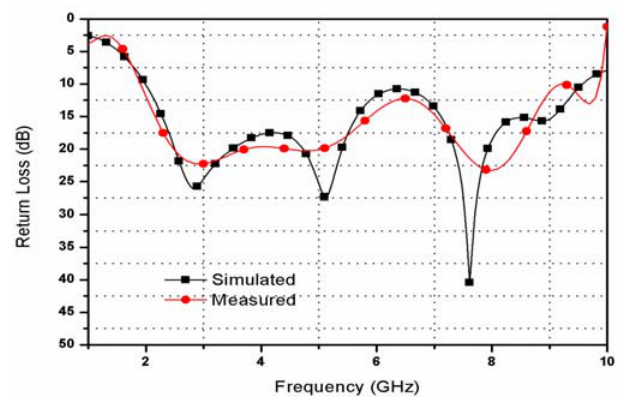
Figure 9: Simulated and measured return loss against frequency for the octagonal ring shape wideband antenna.